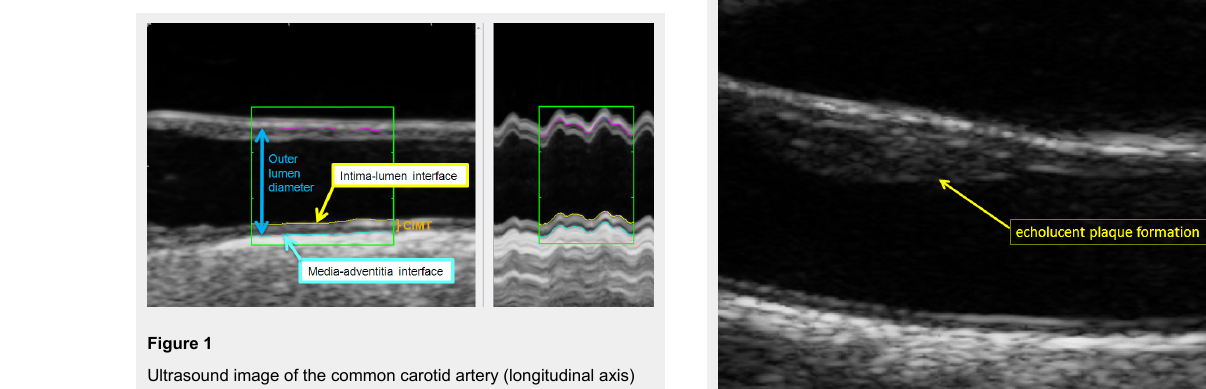
Ultrasound image of the common carotid artery (longitudinal axis) with tracing lines of automatic contour-detection at the lumen- intima- (yellow line) and the media- adventitia interface (blue line). Outer lumen diameter (between blue- and pink-coloured line) in the common carotid artery in B-mode (left) over two heart cycles and with M-mode (right) generated by 180 single images of a this clip. The mean CIMT at the far wall was 0.87 mm.